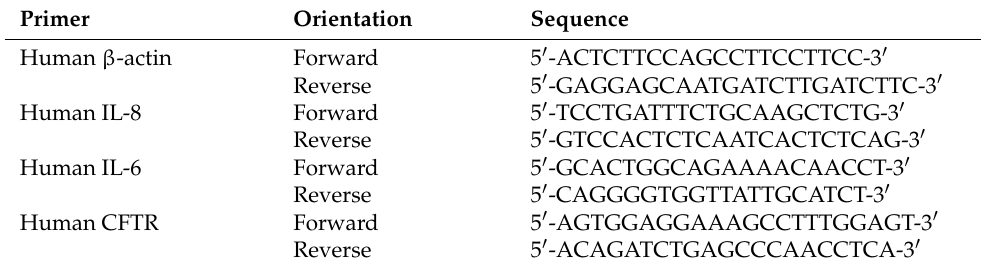
Table 1. Primers used for quantitative